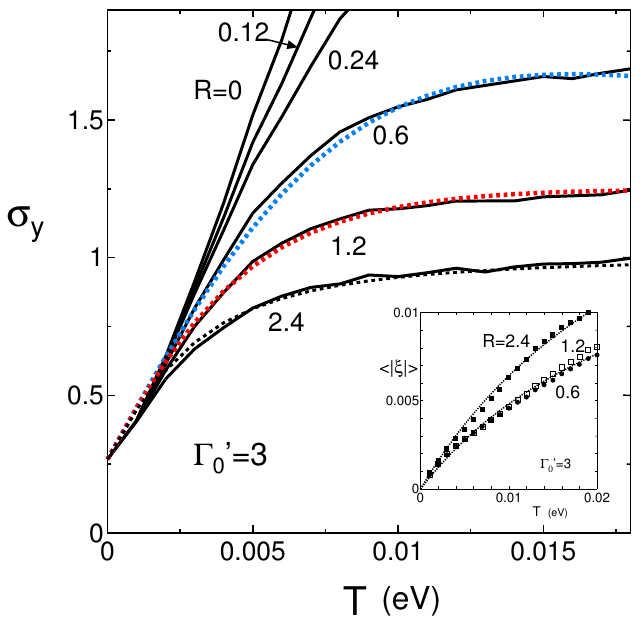
= 3 for R = 0, 0.12, 0.24, 0.6, 1.2, and 2.4 (solid line). Figure 5. (Color online) T dependence of σ y with Γ (cid:48) 0 The dot line denotes a fitting one obtained from Equation (17). The symbols in the inset denotes < | ξ | > obtained from Equation (18b), which are fitted by the dot